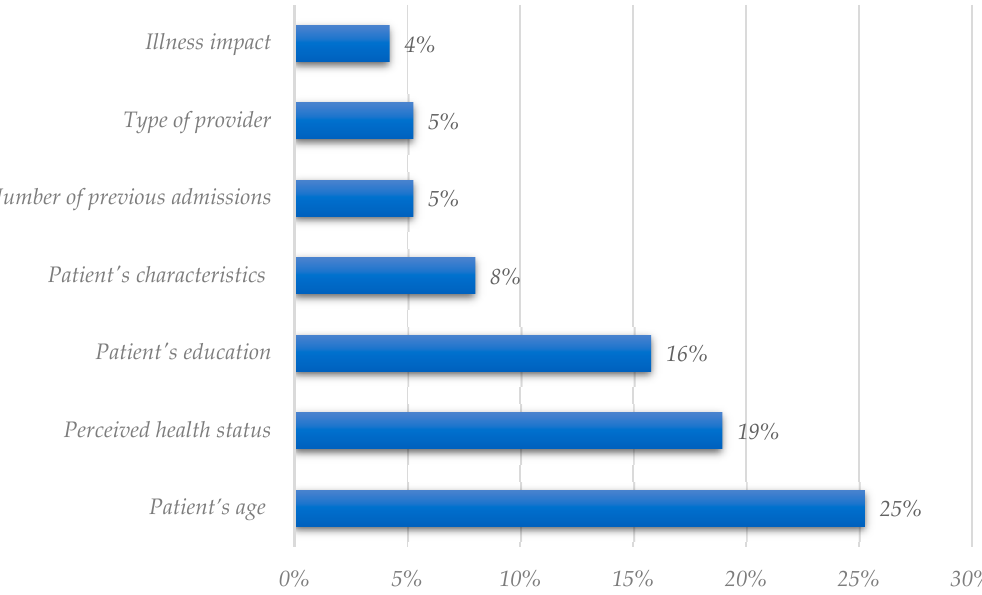
Figure 5. Analysis of explanatory variables deemed as the most critical in the literature (global analysis).